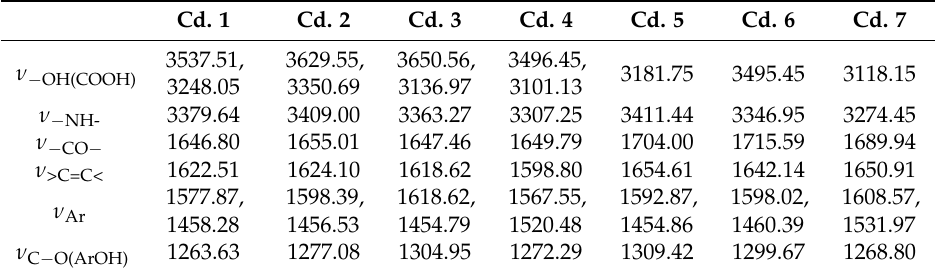
Table 2. The IR data of Cds. 1 – 7 (KBr pellets, ν max , cm − 1 ).